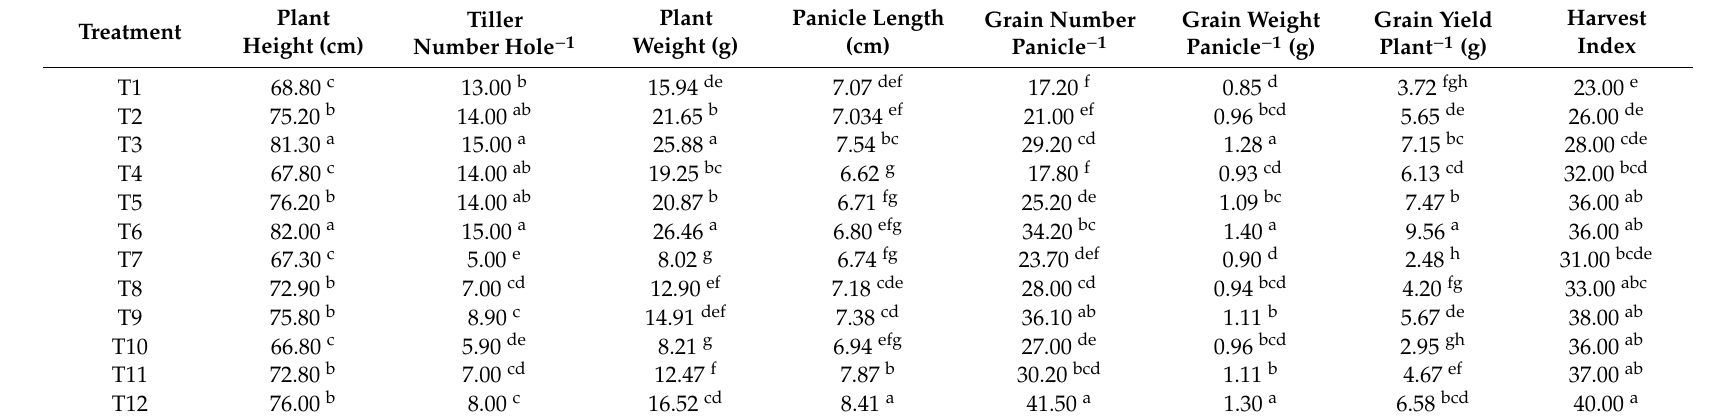
Table 4. Summarized e ff ects of temperature, fertilizer and soil moisture on yield attributes of